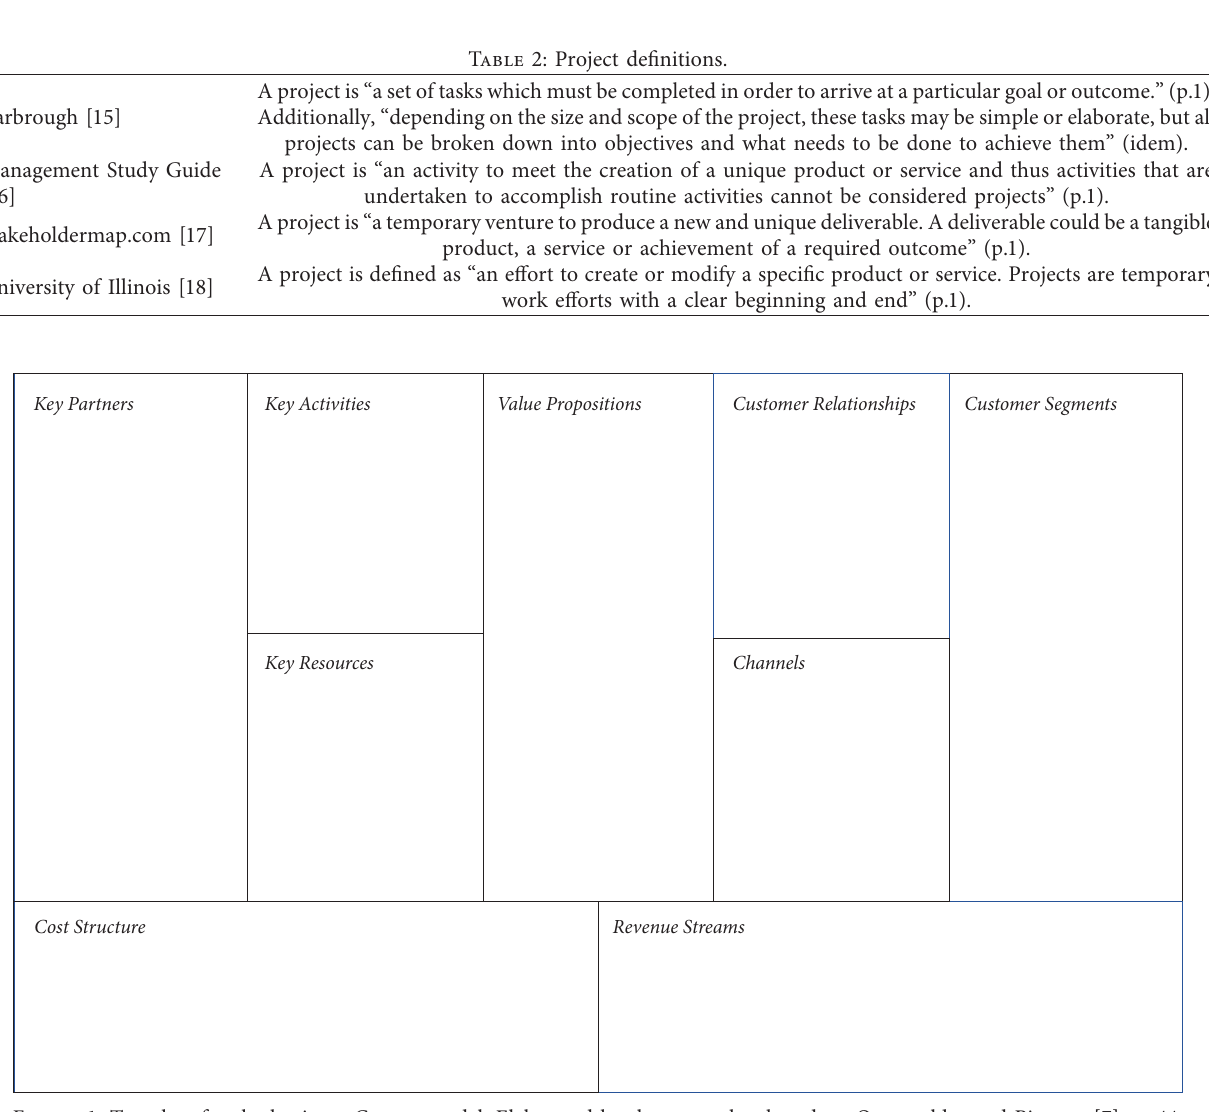
Figure 1: Template for the business Canvas model. Elaborated by the researcher based on Osterwalder and Pigneur [7], p. 44.